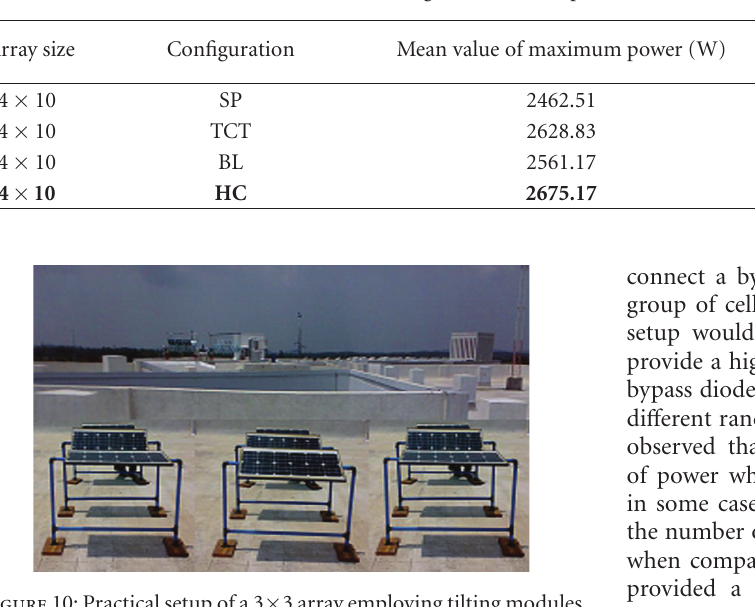
Table 7: Mean value and range of maximum power for 14 × 10 configuration shown in Figure 12.